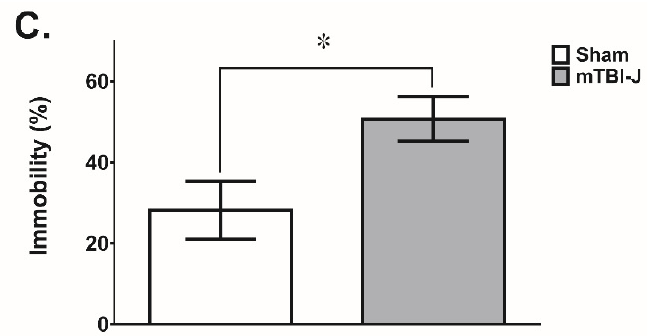
Figure 3. Examine the depression-like behavior in the mTBI-J rats. ( A ) The preference ratio of the mTBI-J group in the sucrose preference test was decreased compared with the sham group (two-way ANOVA, p = 0.0079). ( B ) The average preference ratio was summarized, and a significant difference was found among the mTBI-J and sham control groups. ( C ) The immobility percentage in the forced swimming test was significantly increased in the mTBI-J animals. Data was presented as a mean ± SEM (* = p < 0.05, ** = p < 0.01).